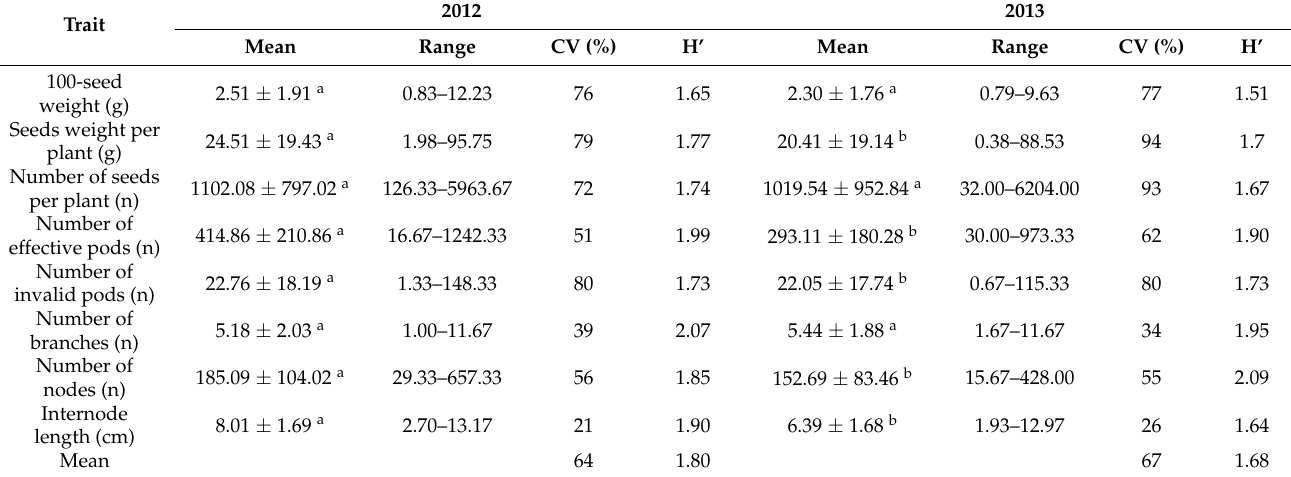
Table 4. Mean, range, coefficient variation, and diversity index of the agronomic traits evaluated in years 2012 and 2013. Trait